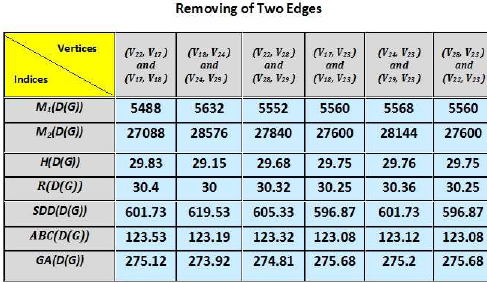
Fig. 5 Removal of two edge sets of healthy Liver